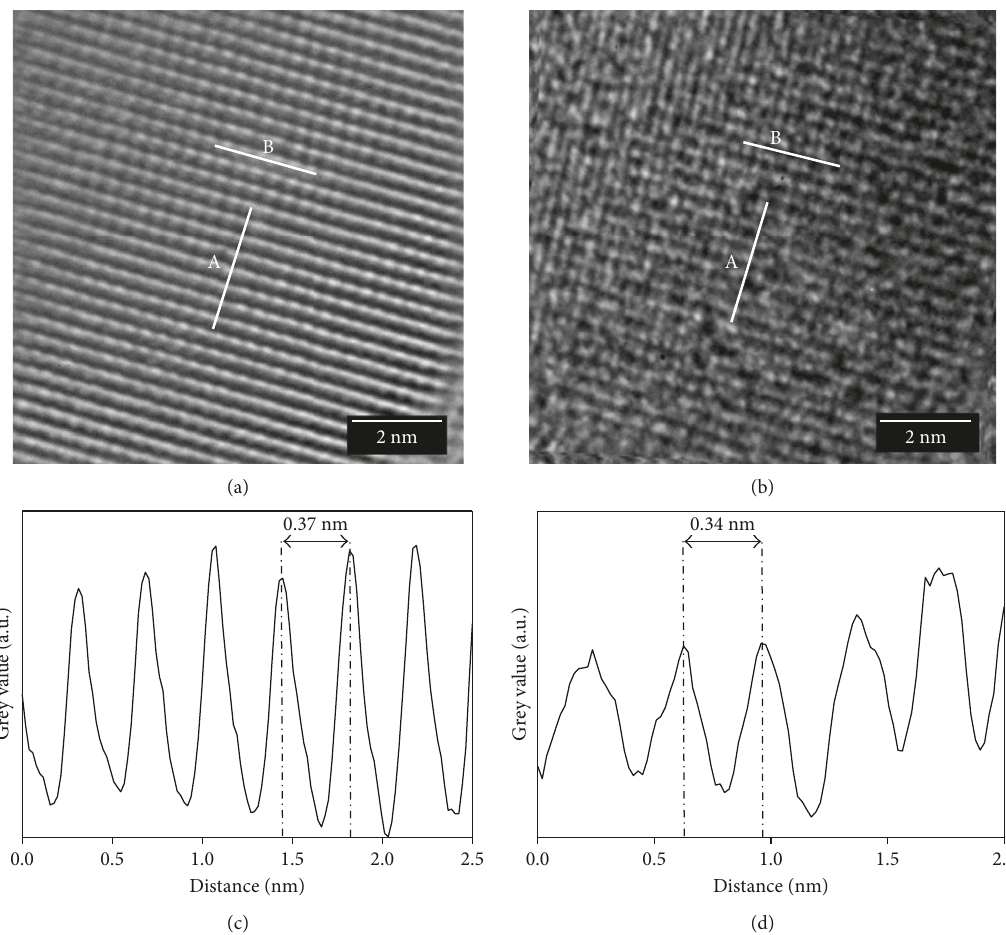
Figure 2: Cs-corrected scanning electron microscope: (a) LiNbO 3 lattice with no RHT; (b) LiNbO 3 lattice after the RHT; (c) interatomic distance with no RHT; (d) interatomic distance with